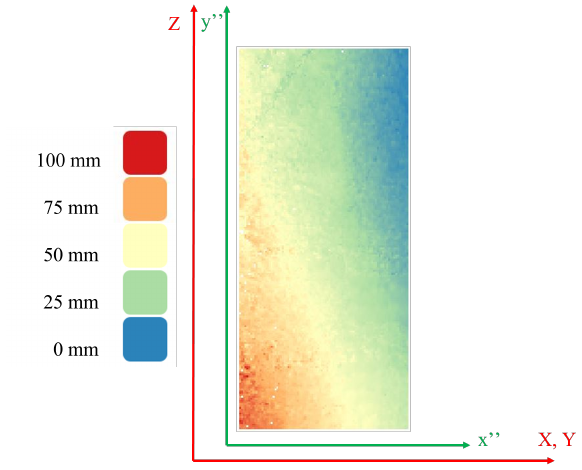
Figure 9. Deviation of the wall from